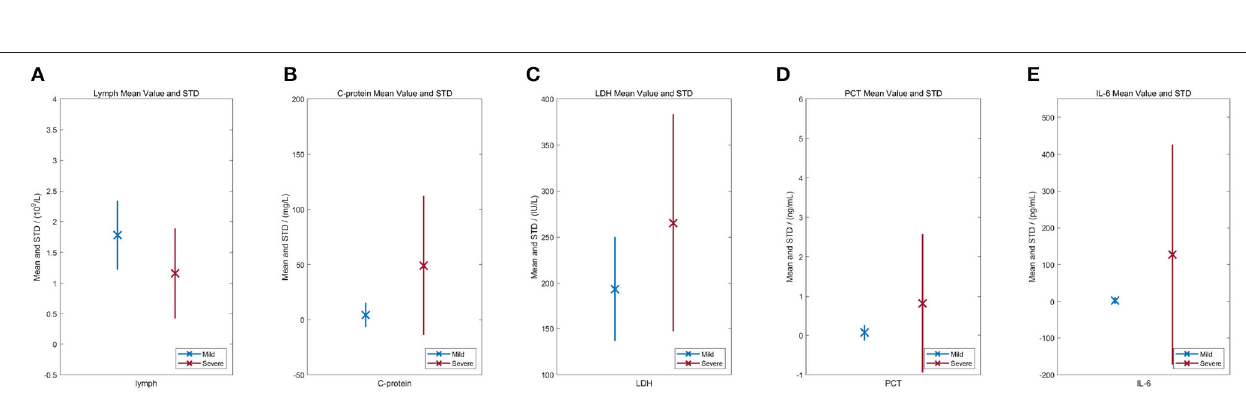
exploiting ultrasound images and biomedical indices.